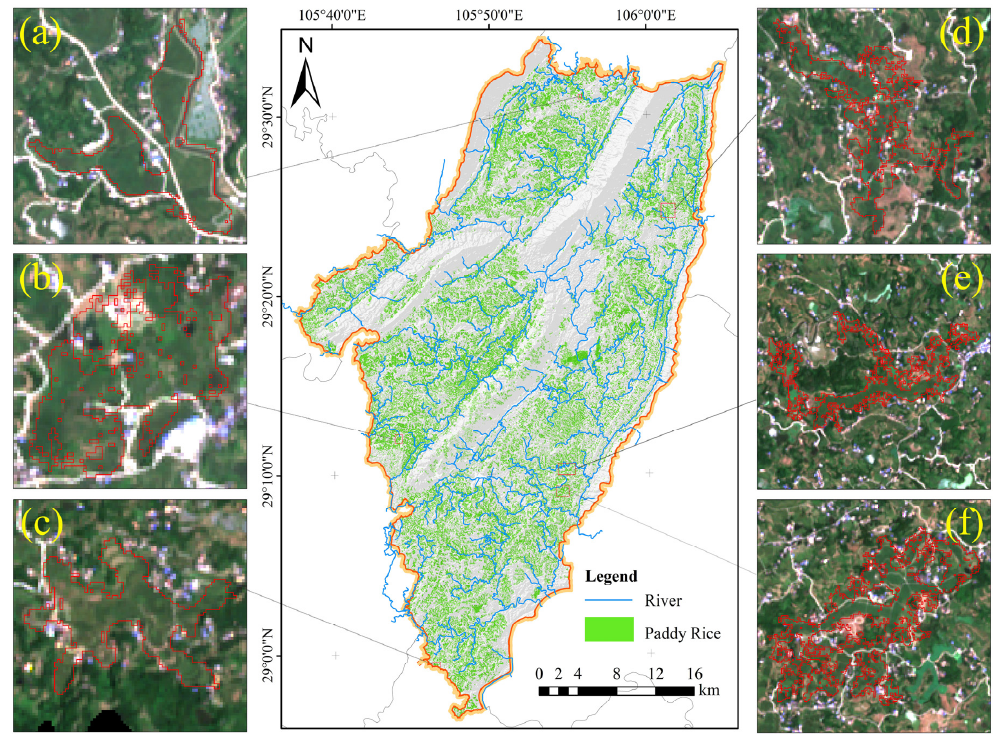
Figure 10. Spatial distribution of paddy rice fields in Yongchuan District. Subplots: ( a – f ) represent the comparison between the detail map of paddy rice extraction results and remote sensing images in six randomly selected regions.